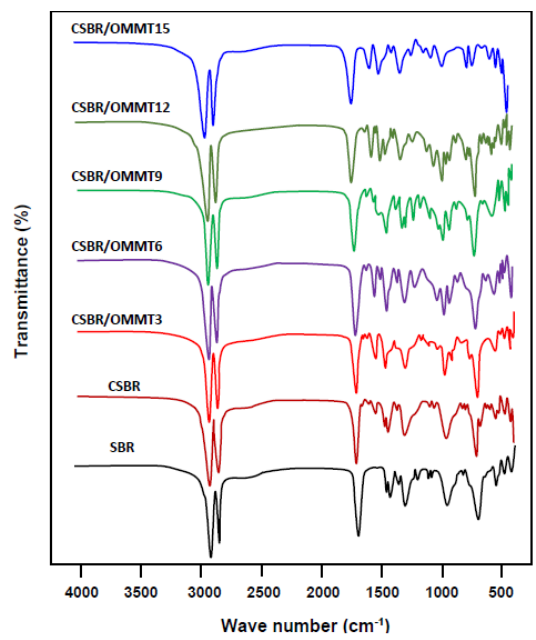
Membranes 2021 , 11 , x FOR PEER REVIEW 10 of 26